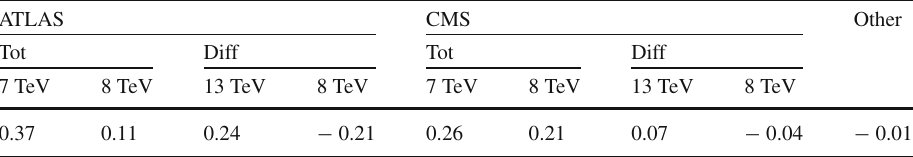
(cid:13) P sim the simplified result (thus ); the result with the same shift, but II with the correlations included exactly (thus P II ), and the NNLO result withnoMHOU. Inthemiddlepanelsthesameisshown, butnormalized (cid:12) to the uncorrelated result. In the lower panels we show the fractional P con ); reduction in the PDF uncertainty and the theory uncertainty due to the II inclusion of the correlations